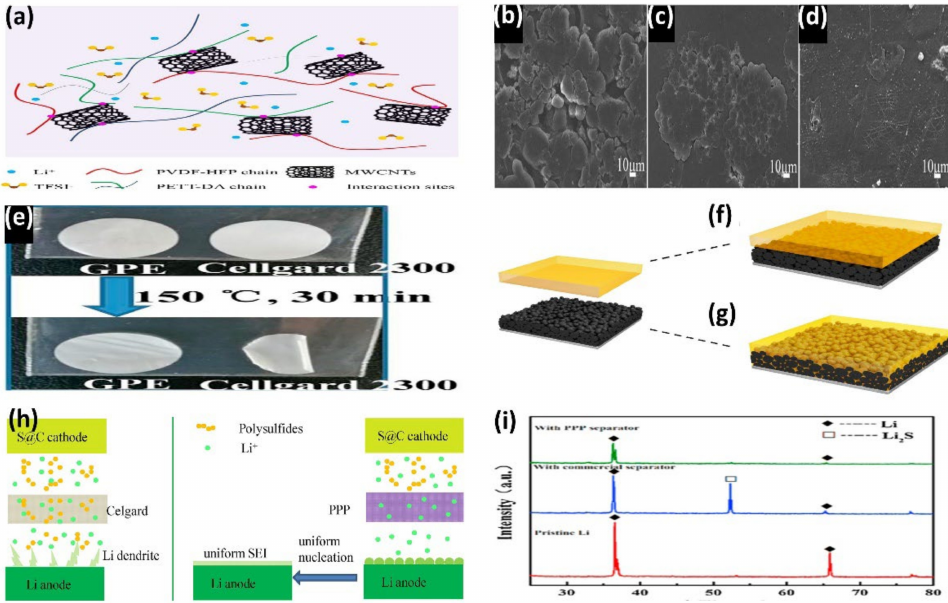
Figure 2. ( a ) Schematic of UPHC 3D polymer network formed by intermolecular hydrogen bonding effect (Reprinted with permission from [36]; Copyright 2020, Chemical Engineering Journal). SEM image of Li anode in Li symmetric cell after 20 cycles of plating/stripping with different electrolytes